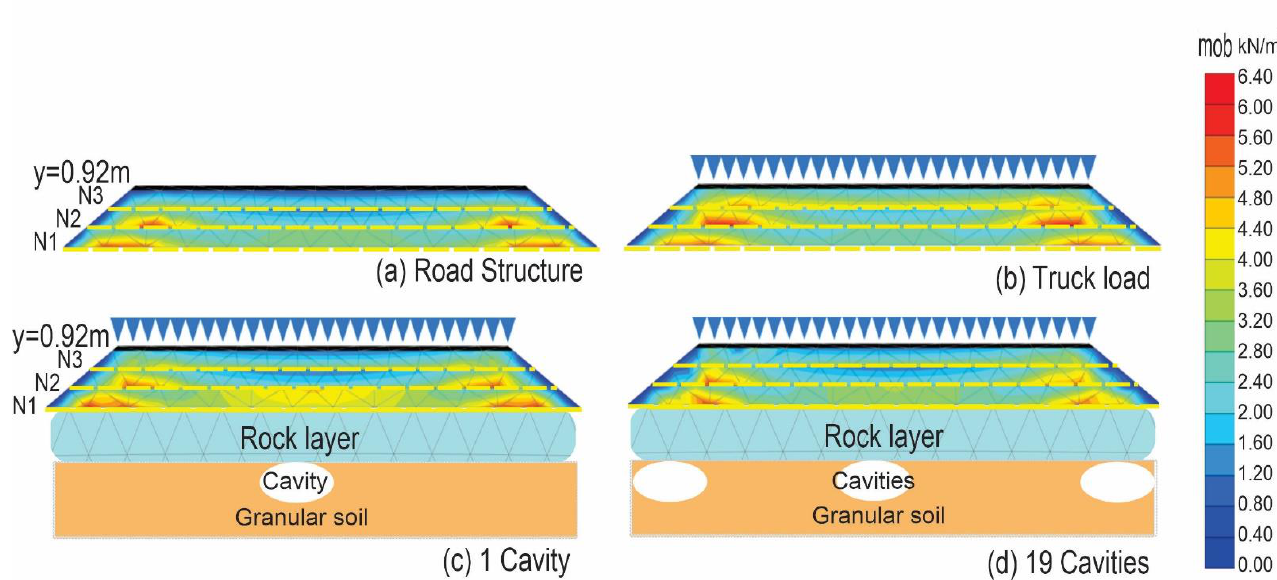
Figure 12. Kinematics for the Case 3 ( N 1 , y = 0.0 m, N 2 , y = 0.31 m and N 3 , y = 0.62 m), Mobilized shear stress ( τ mob ) in the road structure, resulted from the FEM analysis with PLAXIS 2D ® . ( a ) Phase without truck load and cavities, ( b ) Phase with truck load and 0 cavities, ( c ) Phase with truck load and 1 cavity and ( d ) Phase with truck load and 19 cavities.